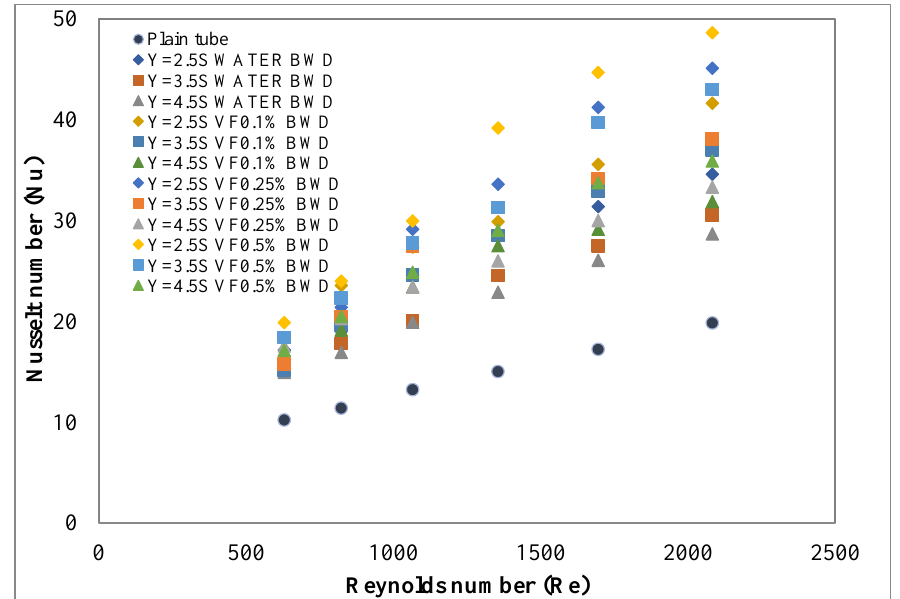
Figure 10. Nusselt number versus Reynolds number for the staggered conical strip insert with a forward arrangement using deionized water and ZrO 2 /deionized water nanofluidsunder laminar flow conditions.